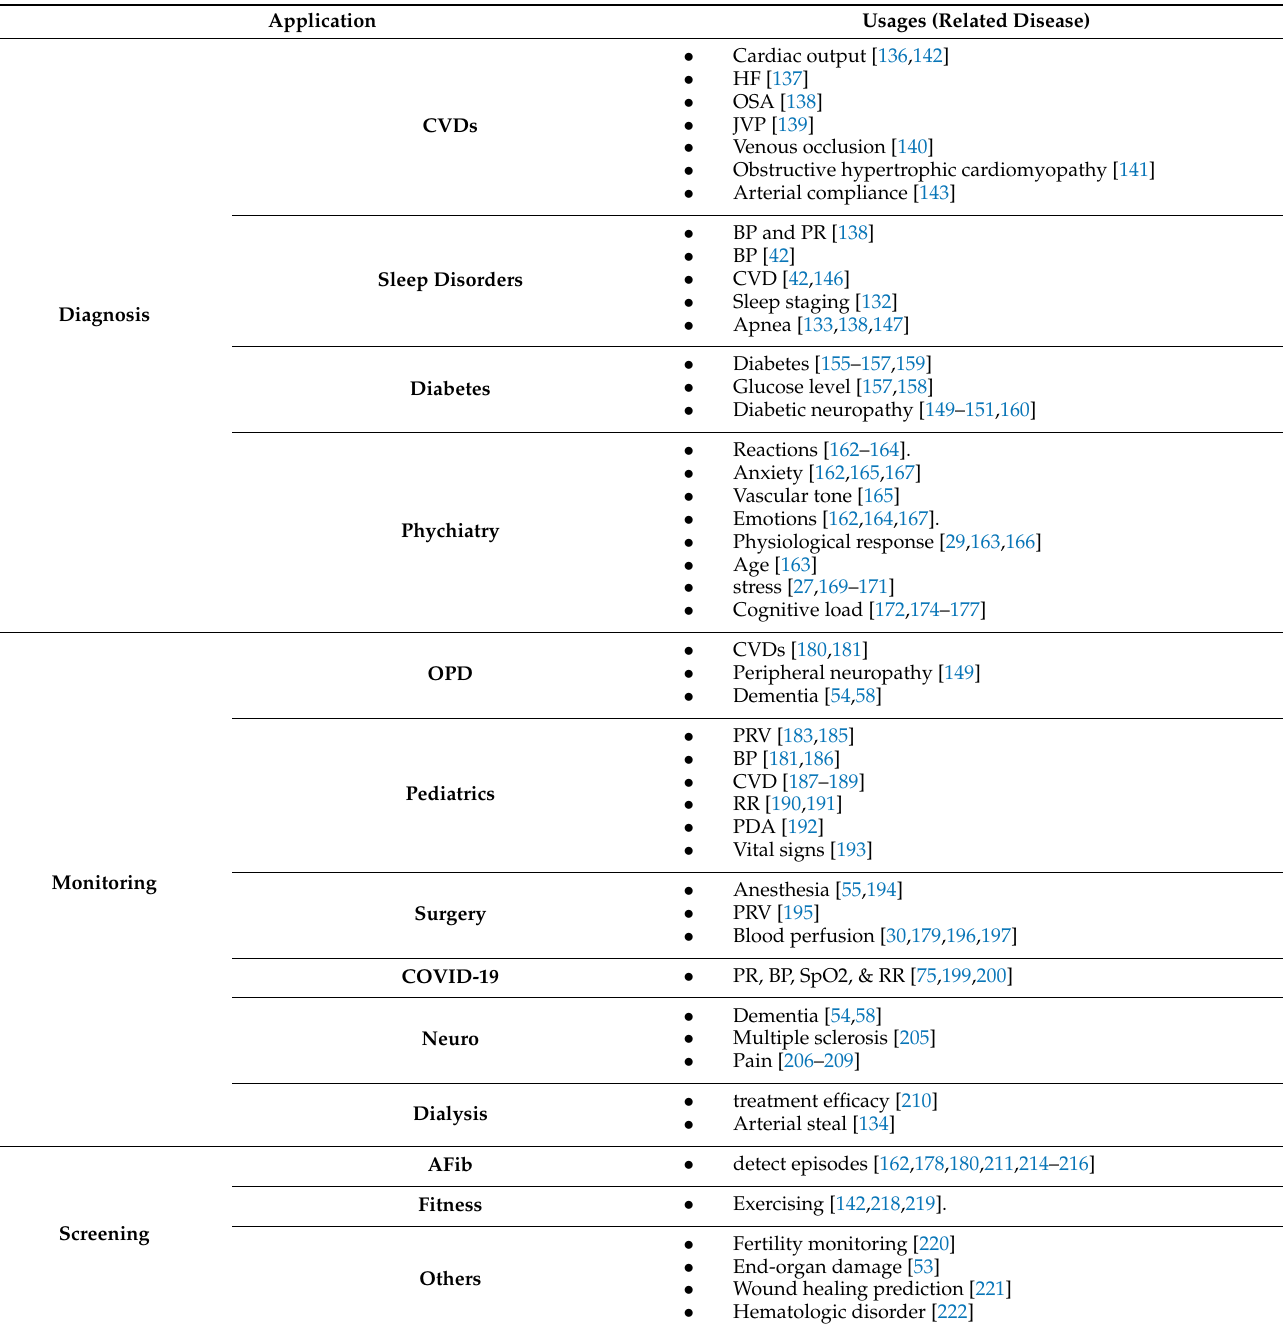
Table 4. Specific applications of PPG signal in healthcare in each